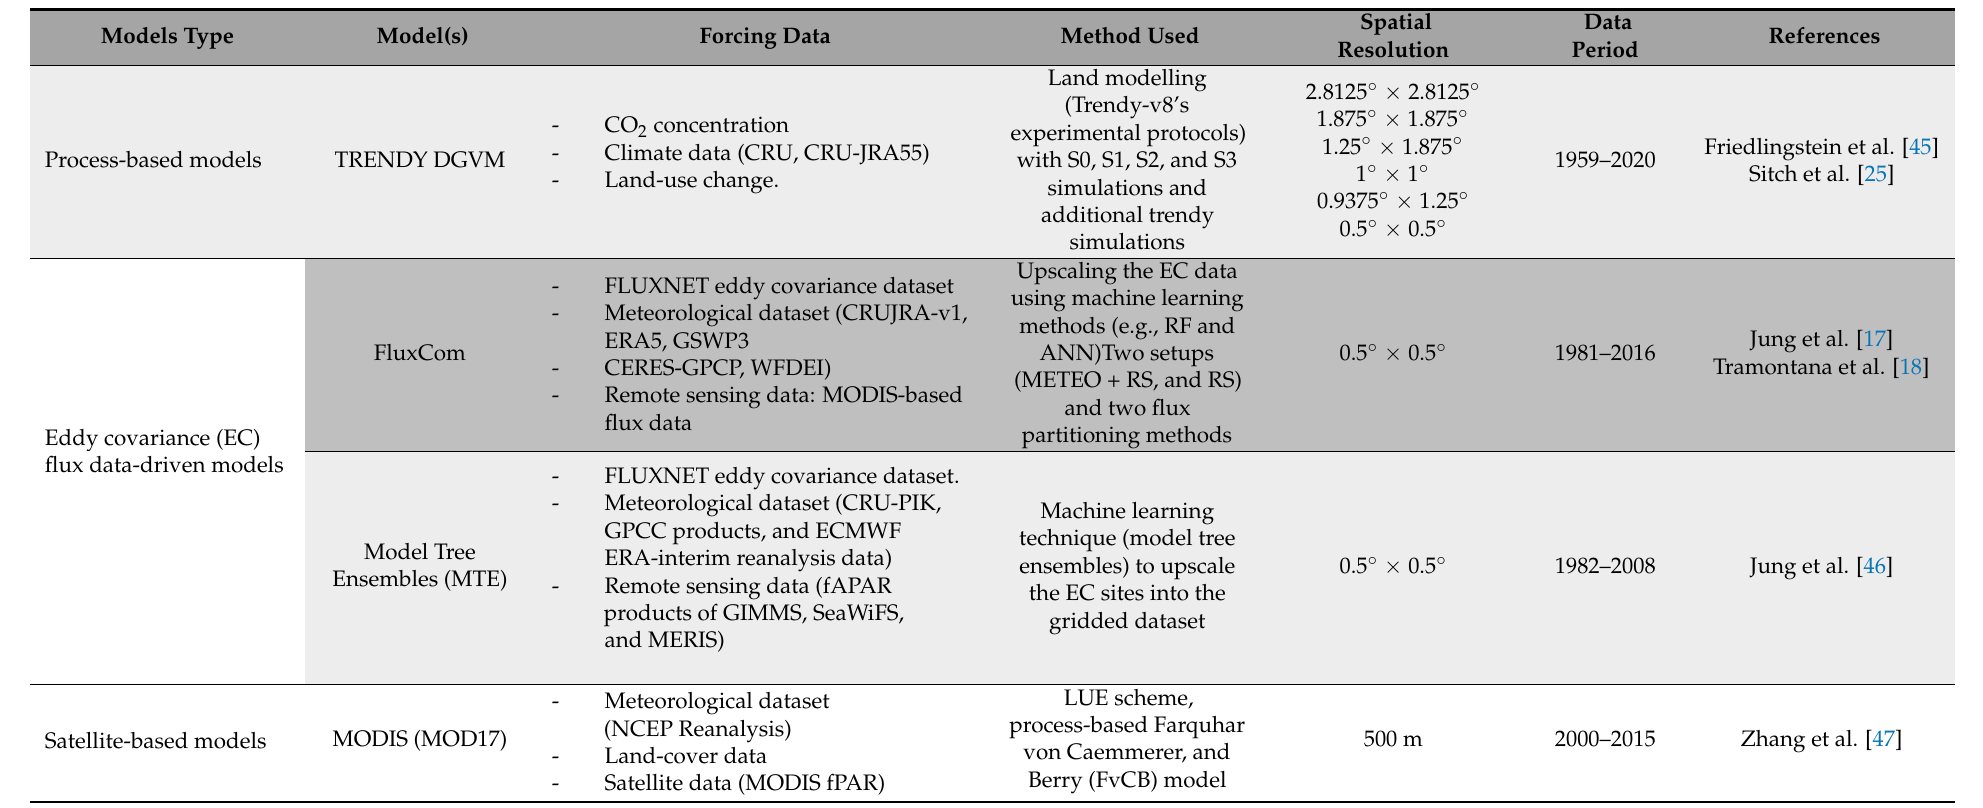
Table 1. The widely used models for the prediction GPP dataset; their structure, forcing data, data period, and spatial